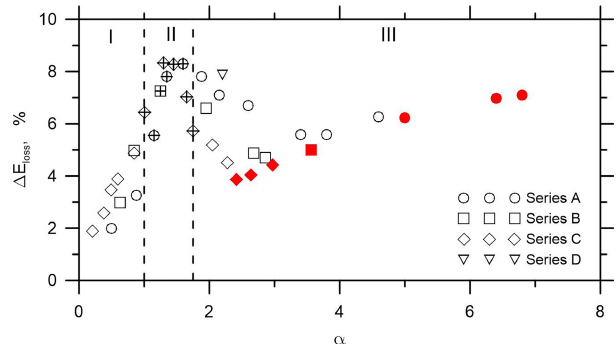
Figure 11. Spatio-temporal diagrams for paths of two ISWs of different amplitudes colliding head-on. (a) Case (A9; A7). (b) Case (A11; A1). The diagrams for the waves without interac- tion are shown by dashed lines.